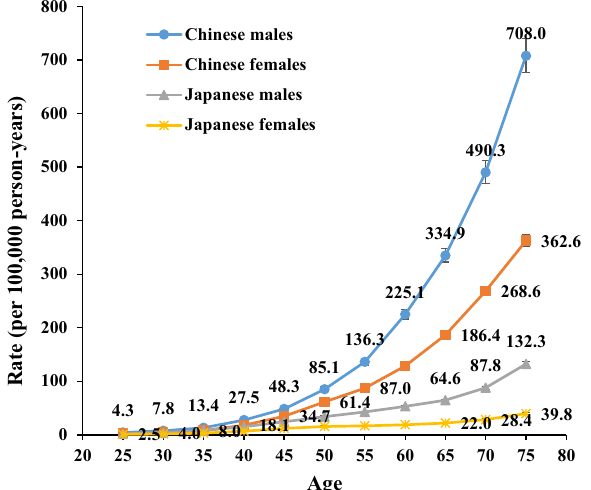
Figure 4. Longitudinal age curves of high SBP-attributable stroke mortality in China and Japan. Fitted longitudinal age-specific rates of high-sodium-intake-attributable stroke mortality (per 100 000 person-years). Error bars represent the 95%CIs for the Longitudinal age curve values. Japanese men 1990: Population: 38 067 229; Stroke: 38 690, 1995: Population: 40 061 997; Stroke: 43 172, 2000: Population: 42 325 105; Stroke: 53